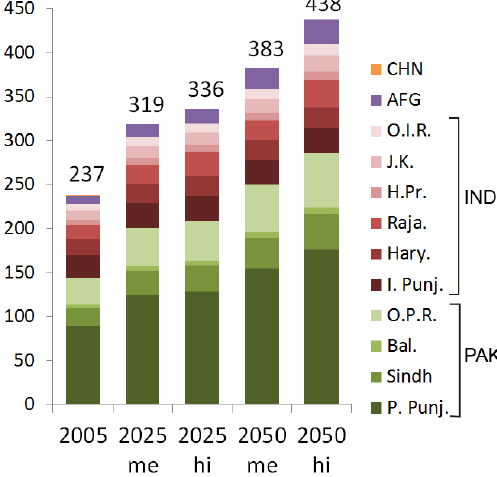
Fig. 6. Population projection data for the different regions within the borders of the Indus basin for 2025 and 2050. The regions and their codes are displayed in Fig. 4; me=medium popula- tion increase estimate; hi=high population increase estimate; data sources: UN (2011) for PAK, AFG and the Indian states of Hi- machal Pradesh, Jammu and Kashmir and other regions, Mah- mood and Kundu (2008) for the Indian states Punjab, Haryana and